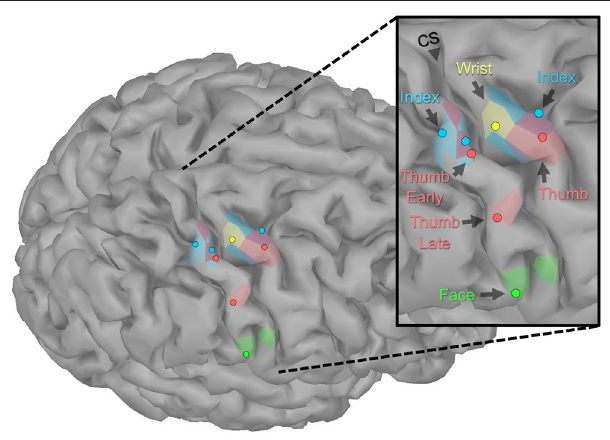
FIGURE 3 | Localization of sensorimotor evoked fields. The peaks of the source activity within the ROIs (shown as dots) showed expected somatotopic organization. The sensory-index task had two equal peaks. The colored regions display the spatial distribution of the source activity within the ROI using manually chosen amplitude thresholds (Sensory: Index 7 pAm, Thumb early 3.5 pAm, Thumb late 5 pAm, Face 20 pAm; Motor: Wrist 8 pAm, Index 6.5 pAm, Thumb 4 pAm). Though the participant had no intact motor or sensory function of his index finger, the expected somatotopic